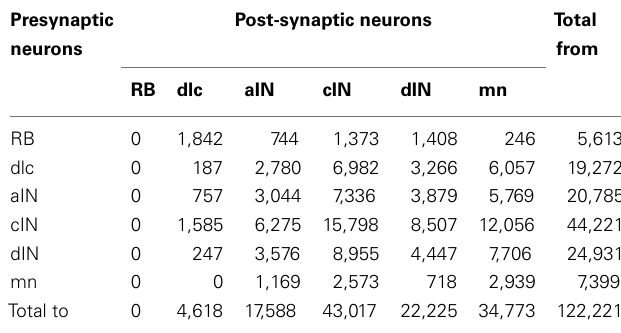
Table 2 | Distribution of connections between all types of presynaptic neurons and all post-synaptic neurons in the connectome. Presynaptic neurons